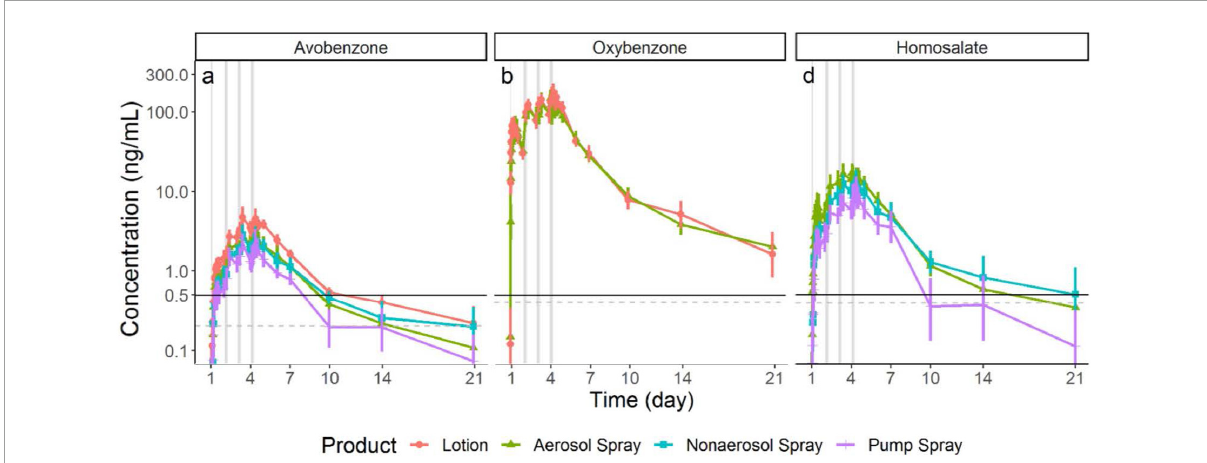
FIGURE1 Division of applied regulatory science (DARS) conducted a clinical study to assess the systemic absorption and pharmacokinetics of sunscreen active ingredients. Study results (shown in these graphs) demonstrate these compounds are absorbed at levels that would trigger additional safety studies. Further research is needed and these findings do not indicate individuals should refrain from using sunscreen (7).